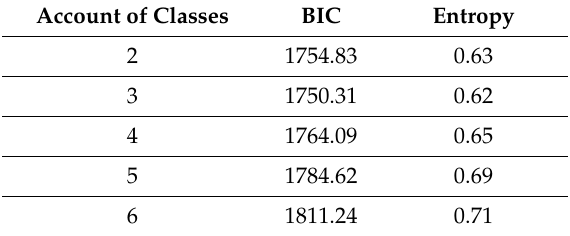
Table 2. Fit indices of the latent profile for all models compared. BIC: Bayesian information